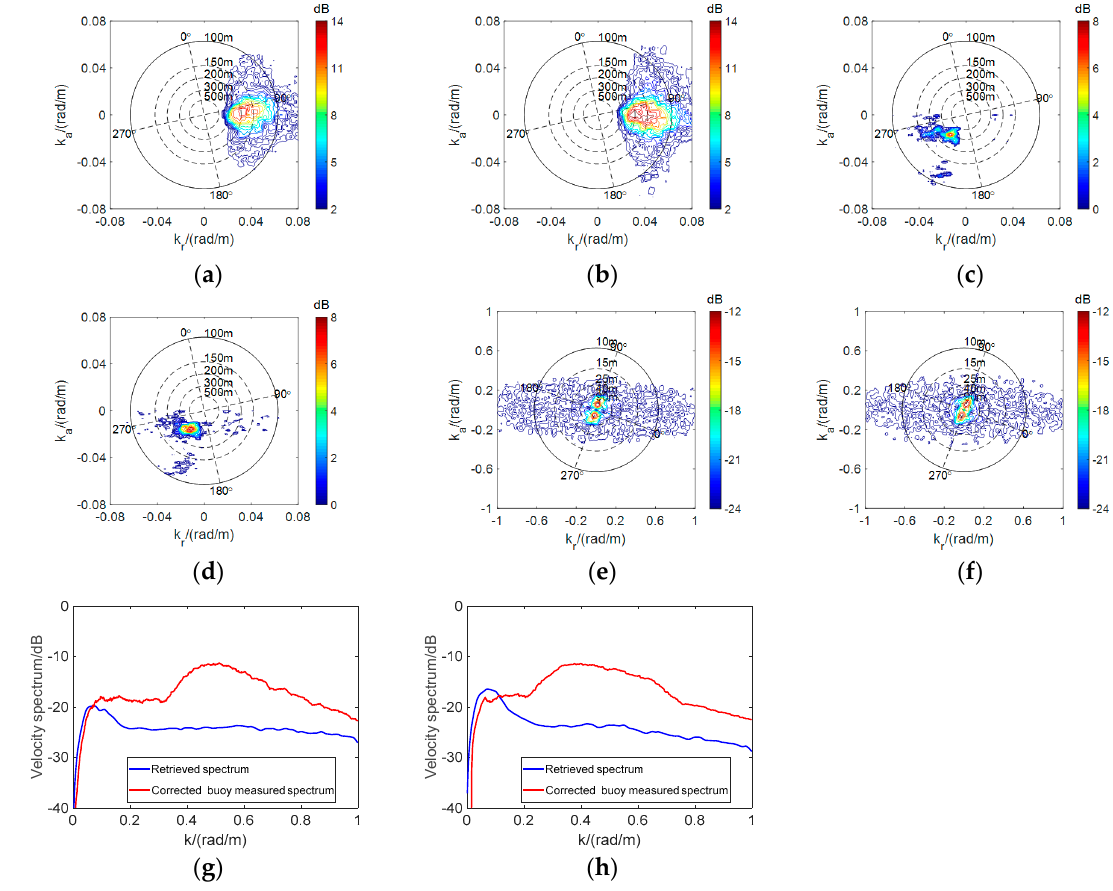
Figure 12. The spectra of the orbital velocities of ocean waves: A 1 ( a ); A 2 ( b ); A 3 ( c ); A 4 ( d ); M920 ( e ); M3120 ( f ); ( g , h ) one-dimensional spectra orbital velocities of ocean waves retrieved and measured, and the blue lines are the one-dimensional spectra of the orbital velocities retrieved using the airborne hybrid InSAR system, and the red line is the one-dimensional orbital velocities spectra measured by the GNSS buoy corrected by low-pass filter.